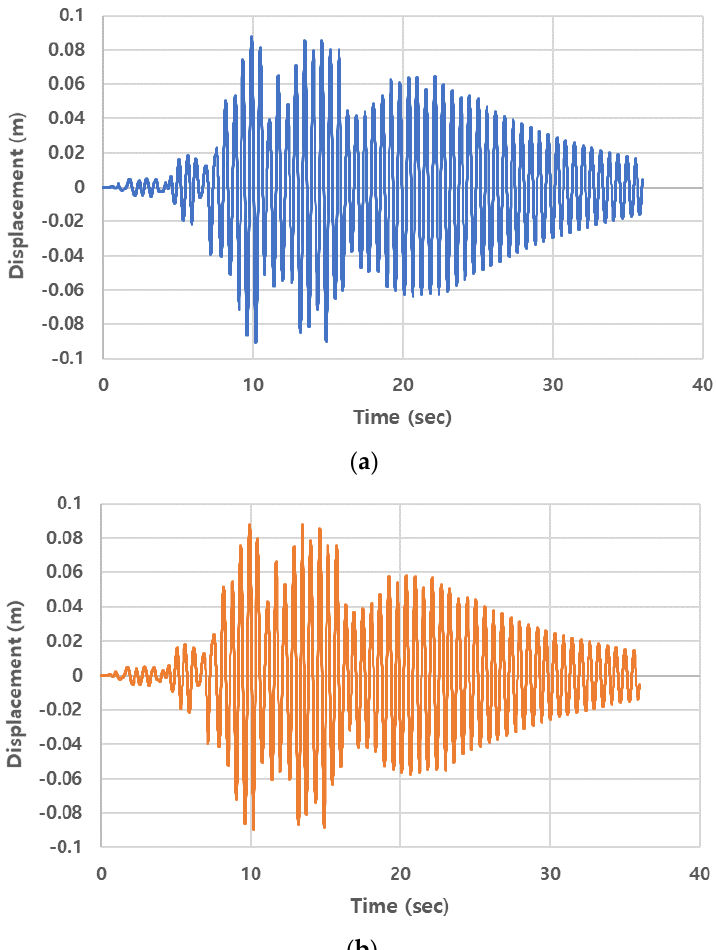
Figure 11. Primary structure displacement at equipment location 3: ( a ) Full FE model; ( b ) Two-DOF Primary structure displacement at equipment location 3: ( a ) Full FE model; model. ( b ) Two-DOF